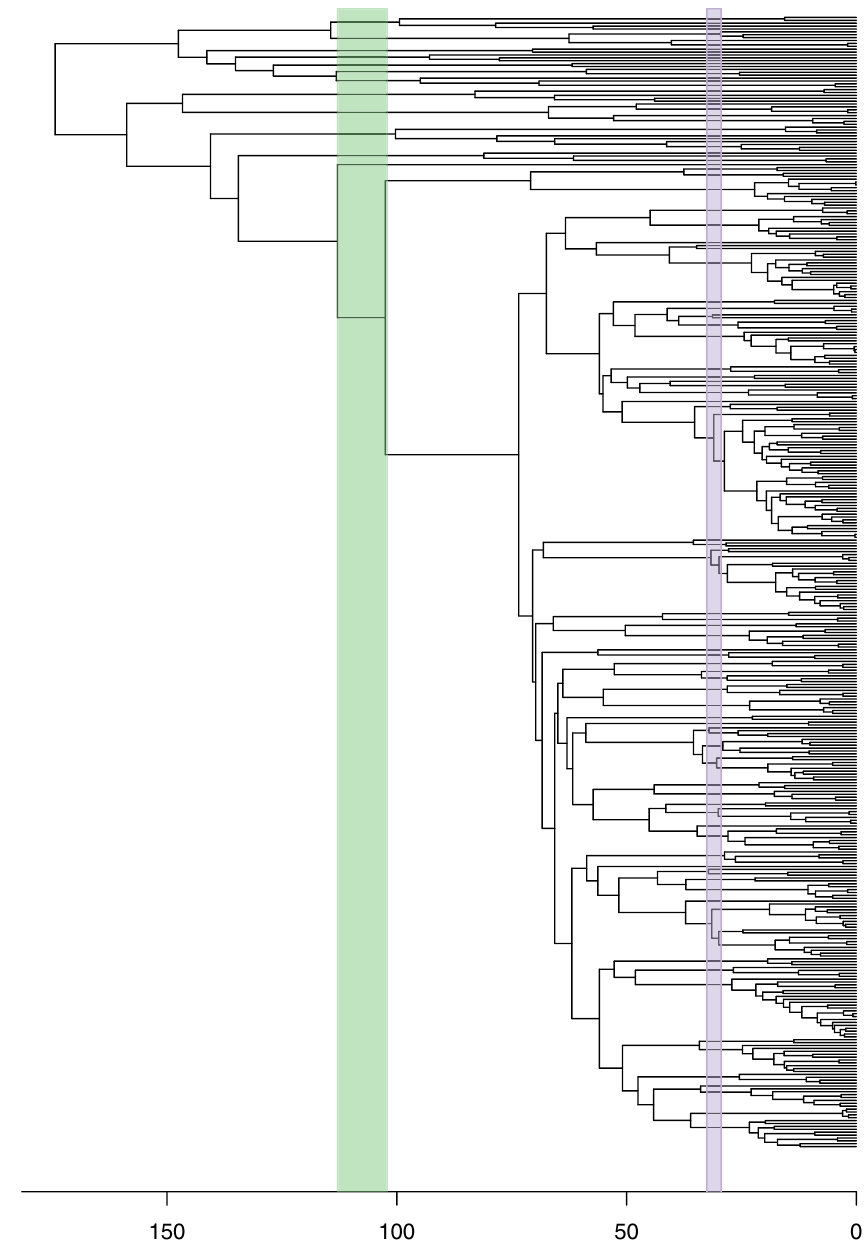
Figure 3. Time-calibrated phylogeny of Parmeliaceae and related families based on a multi-locus data set. Temporal bands for family rank (green) and genus level (pink)